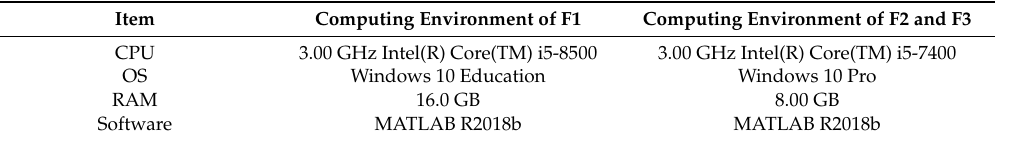
Table 5. Experimental environment of the